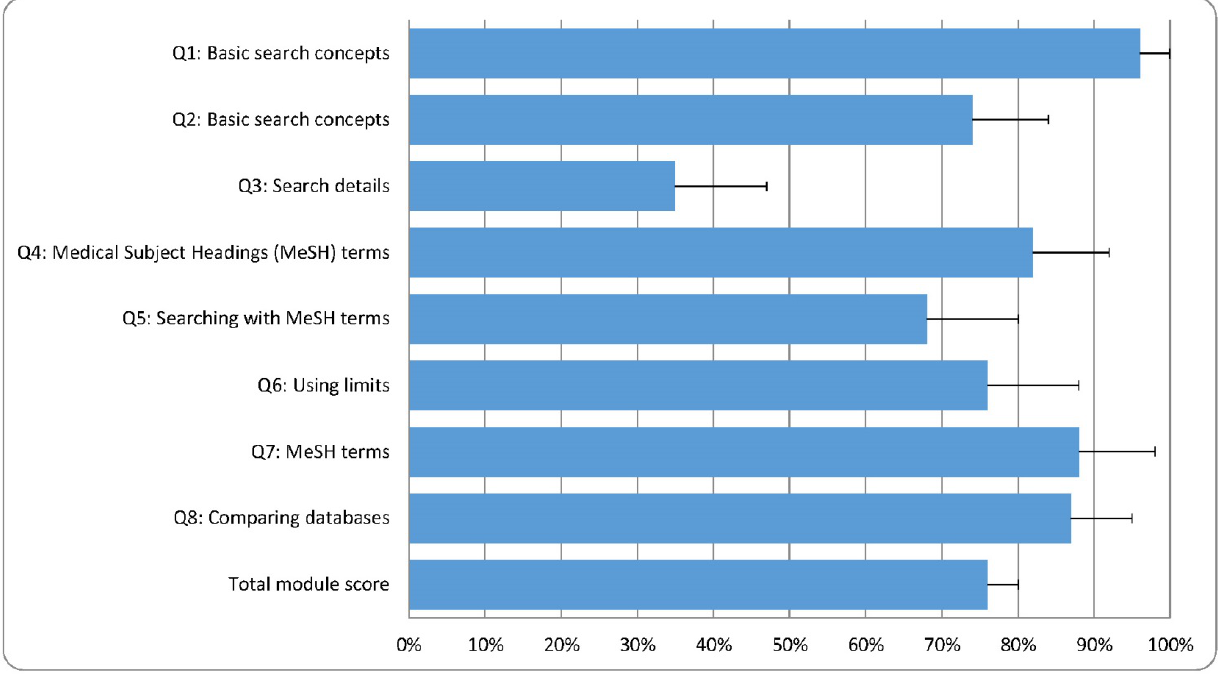
* Data are presented as means (95%